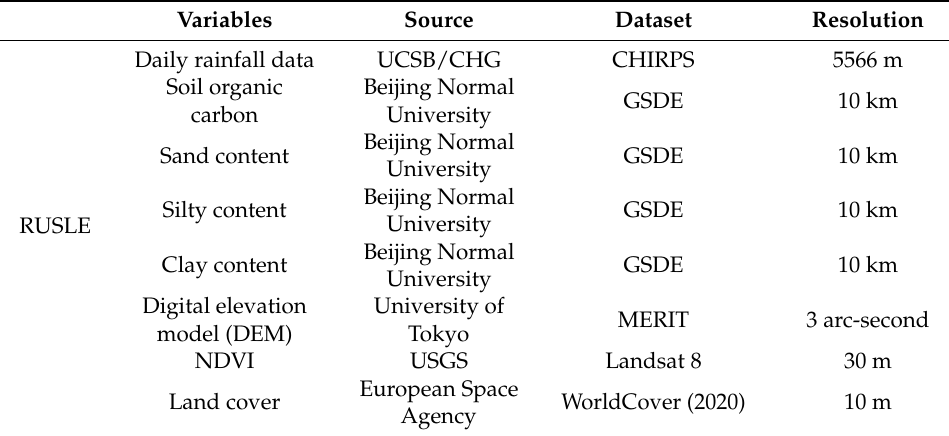
Table 1. Data list, sources, dataset s, and original